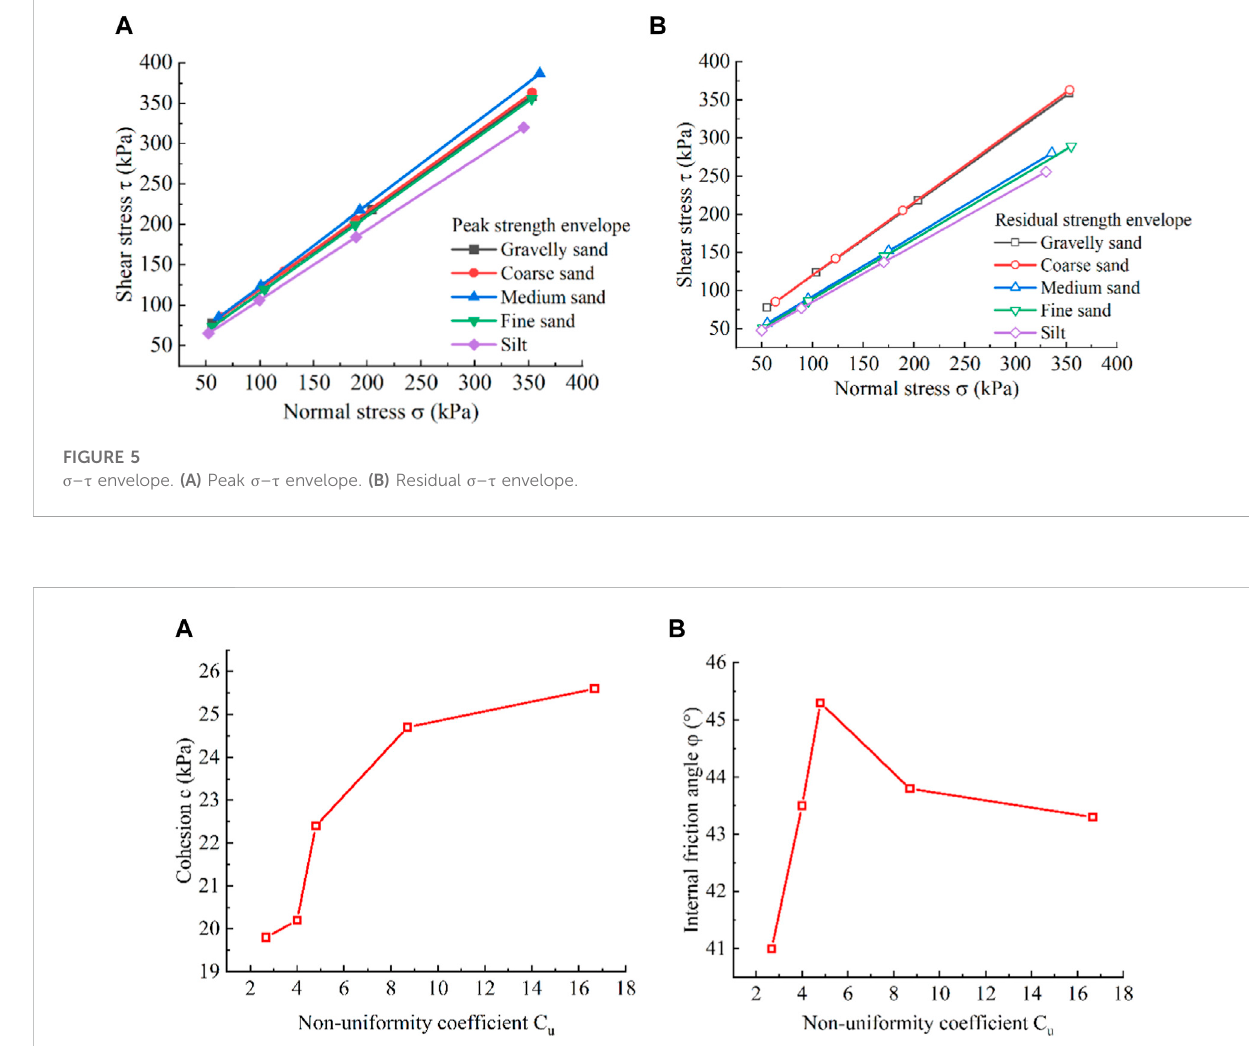
Frontiers in Earth